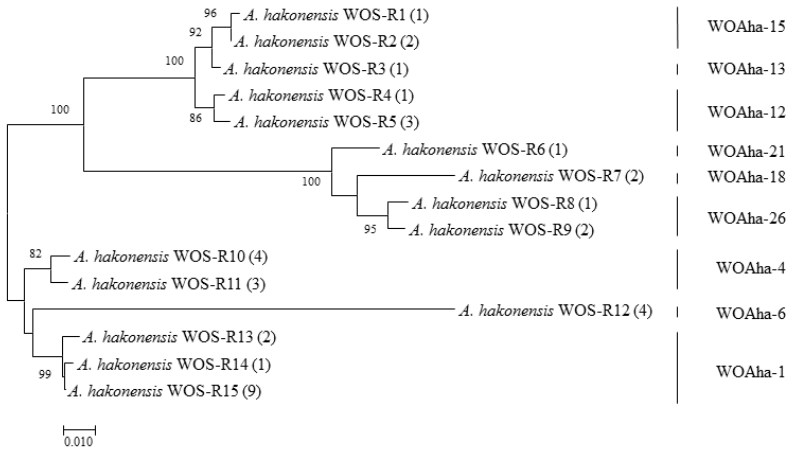
Figure 5. Maximum likelihood tree actively transcribed phage WO types of A. hakonensis based on orf7 sequences using WO-F; WO-R primers. WOS-Rx refers to the serial number. The numbers in parentheses indicate the number of sequences obtained. Phage WO types are shown on the right. Numbers above and below branches are bootstrap values computed from 1000 replications.